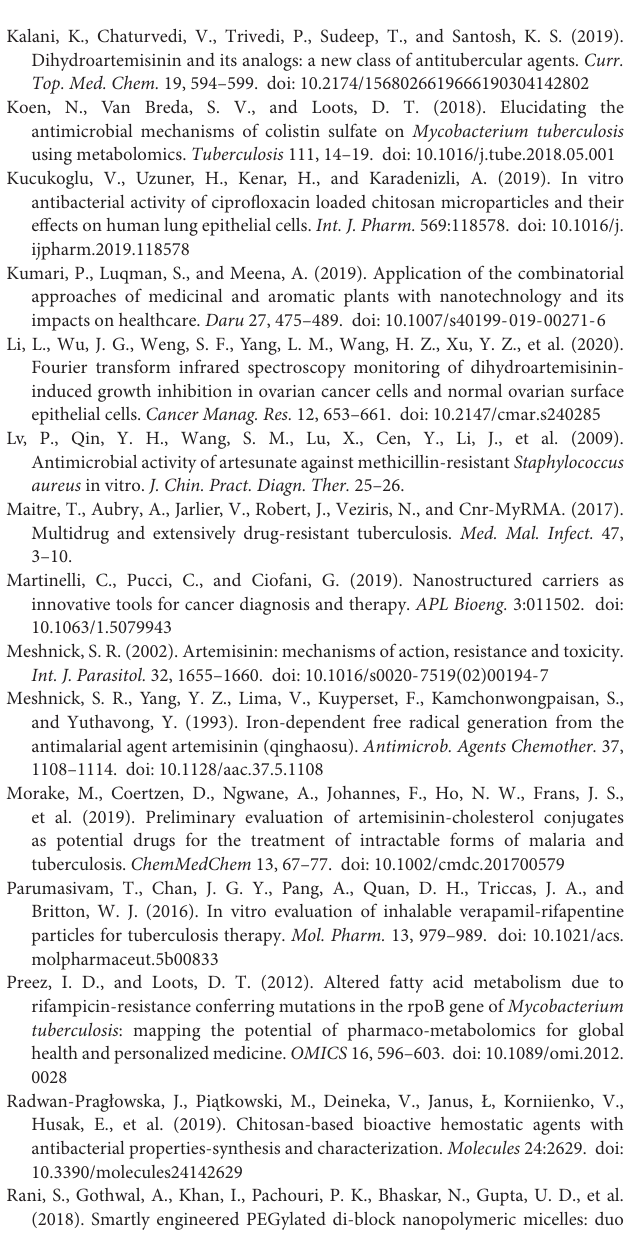
Supplementary Figure 1 | MTB solid drug-sensitive culture